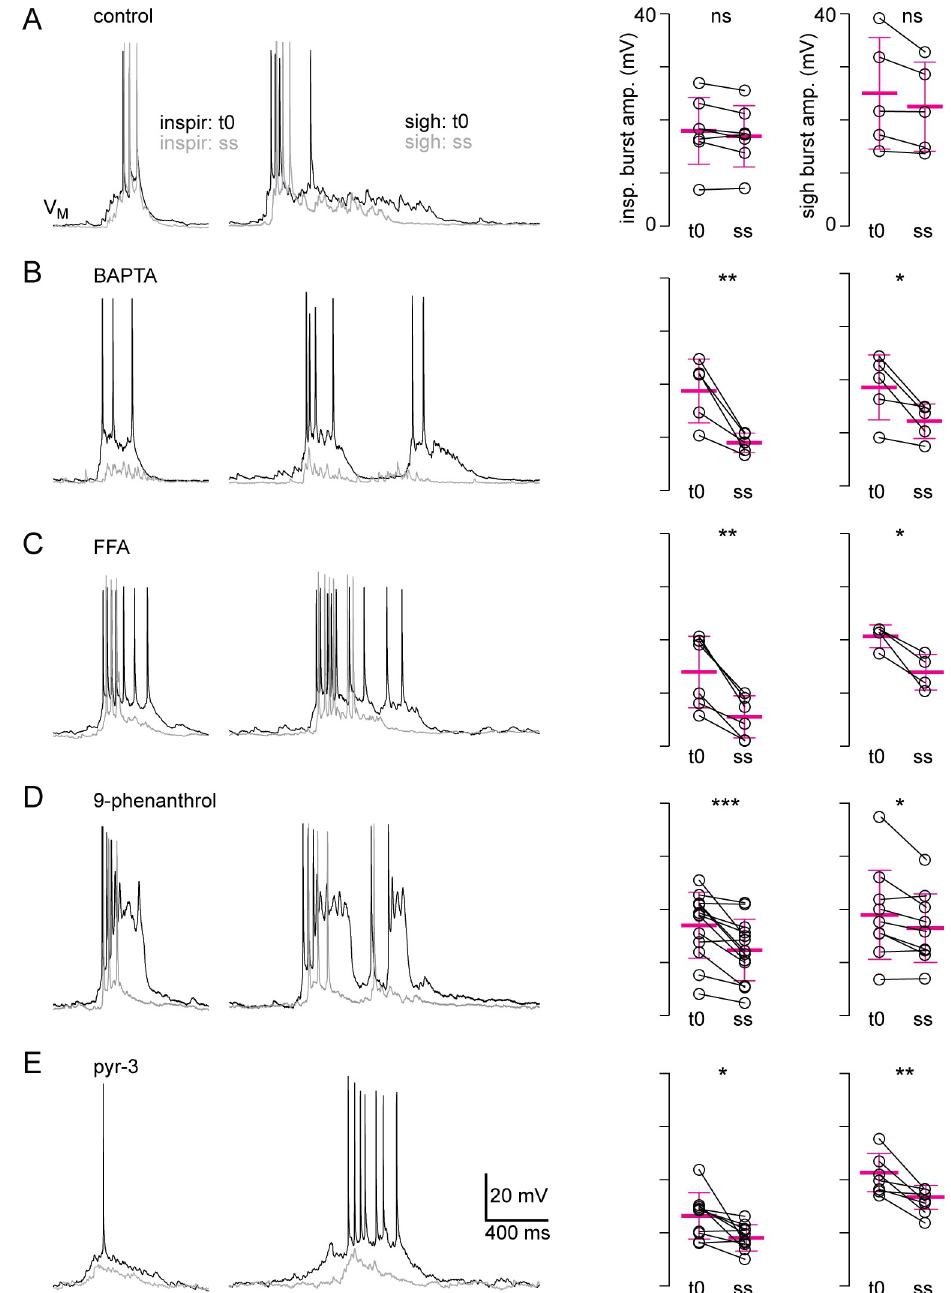
Fig 8. Trpm4 and Trpc3 antagonists attenuate inspiratory and sigh bursts of Dbx1 preBo¨tC neurons. Data are from neonatal Dbx1;Ai9 mice. Each row shows inspiratory (left) and sigh bursts (right) superimposed at the onset of whole-cell recording (t0, black) and at steady-state (ss, gray, following approximately 20 min of whole-cell dialysis or [in the case of pyr-3] bath application). Group data plotted at far right with means and SD bars (magenta). (A) no drug dialysis, (B) BAPTA, (C) FFA, (D) 9-phenanthrol, and (E) pyr-3. Primary data can be found in the Supporting information (S1 Data). BAPTA, (1,2-bis(2-aminophenoxy)ethane- N , N , N 0 , N 0 -tetraacetic acid); Dbx1, developing brain homeobox 1; FFA, flufenamic acid; preBo¨tC, pre-Bo¨tzinger complex; pyr-3, pyrazole-3; Trp, transient receptor